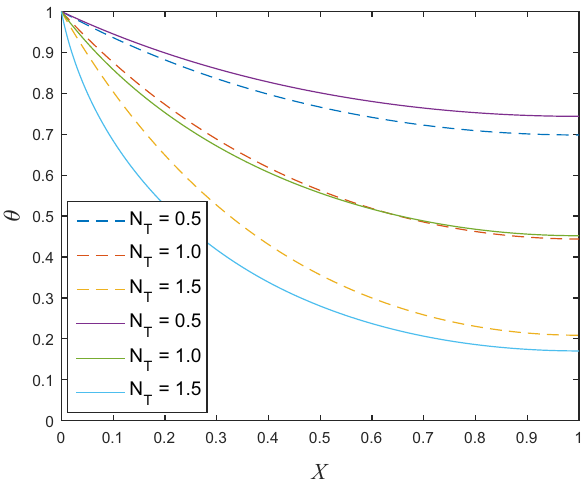
Figure 7: E ff ect of N T (- - linear variation and — non - linear variation ) on the temperature distribution of the fi n.